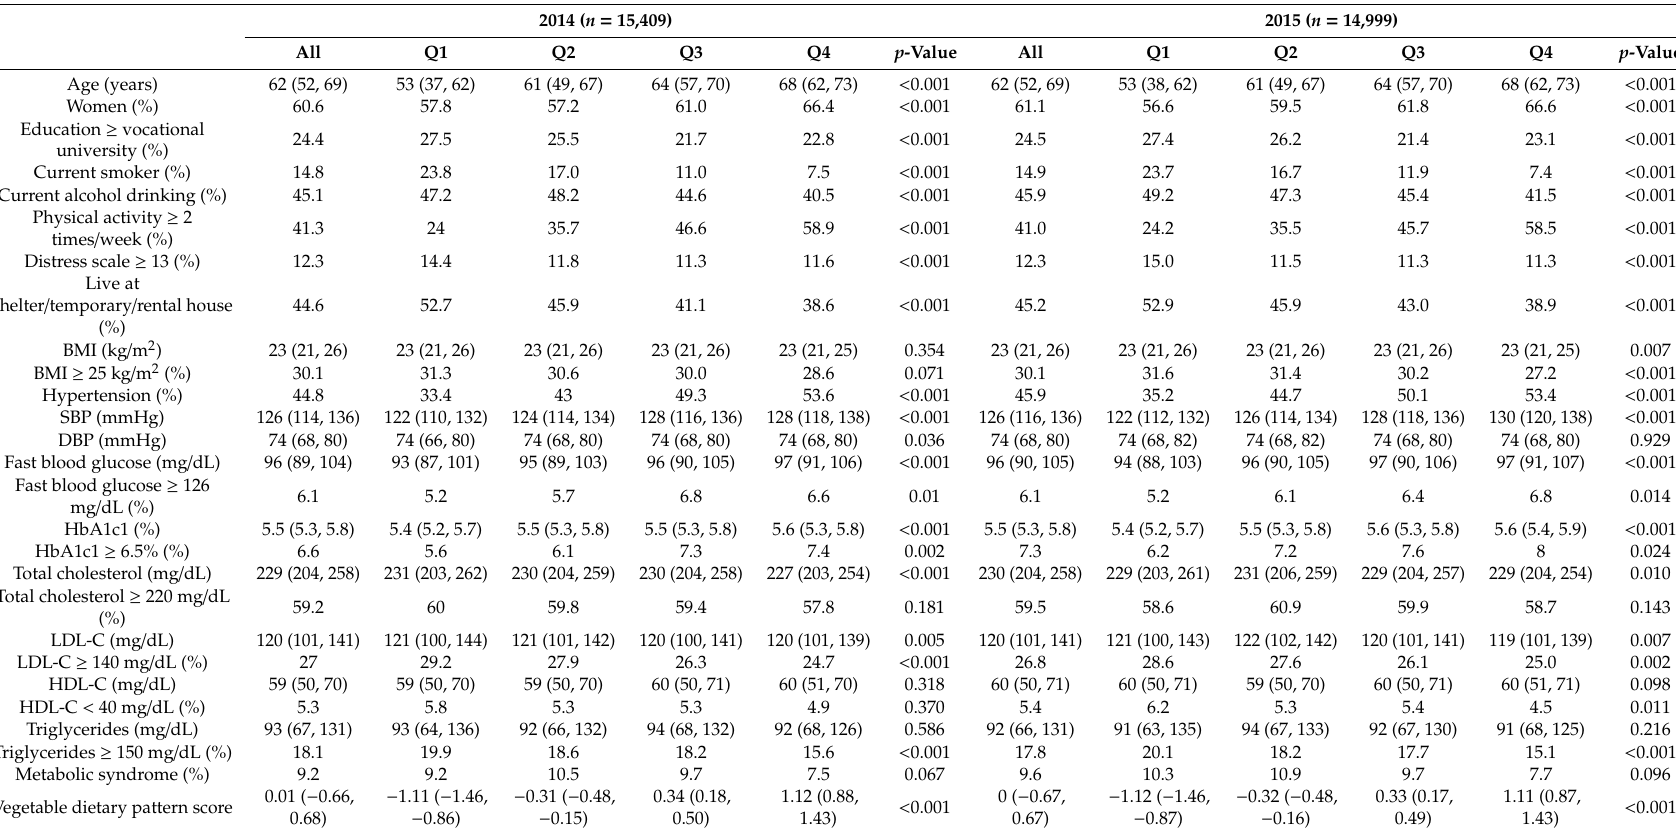
Table 1. Characteristics of participants (2011–2013) and their health checkup results (2014–2015) stratified by the cumulative means of vegetable dietary pattern